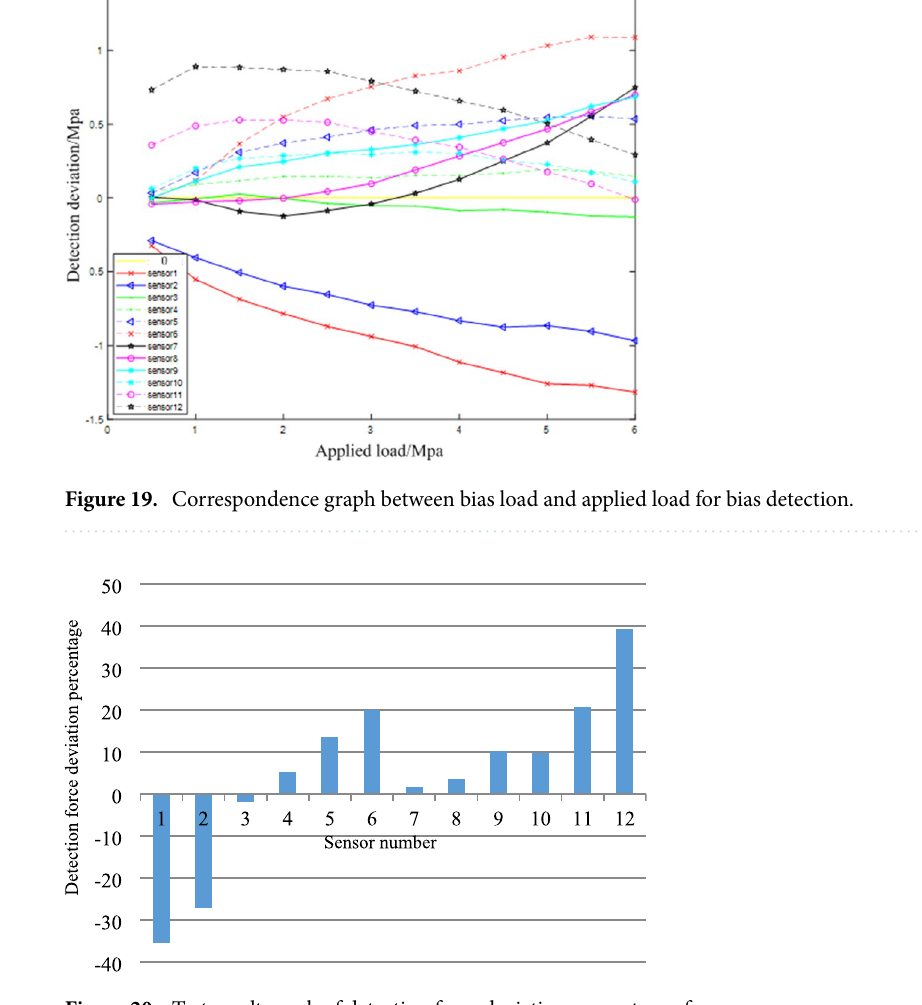
Figure 20. Test result graph of detection force deviation percentage of